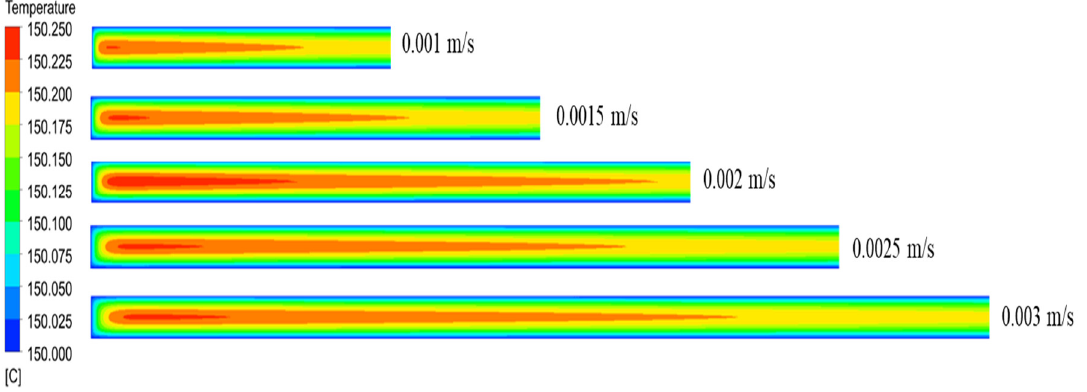
Figure 27. Cloud diagram of temperature distribution in the axial section of the microreactor at different inlet flow rates.